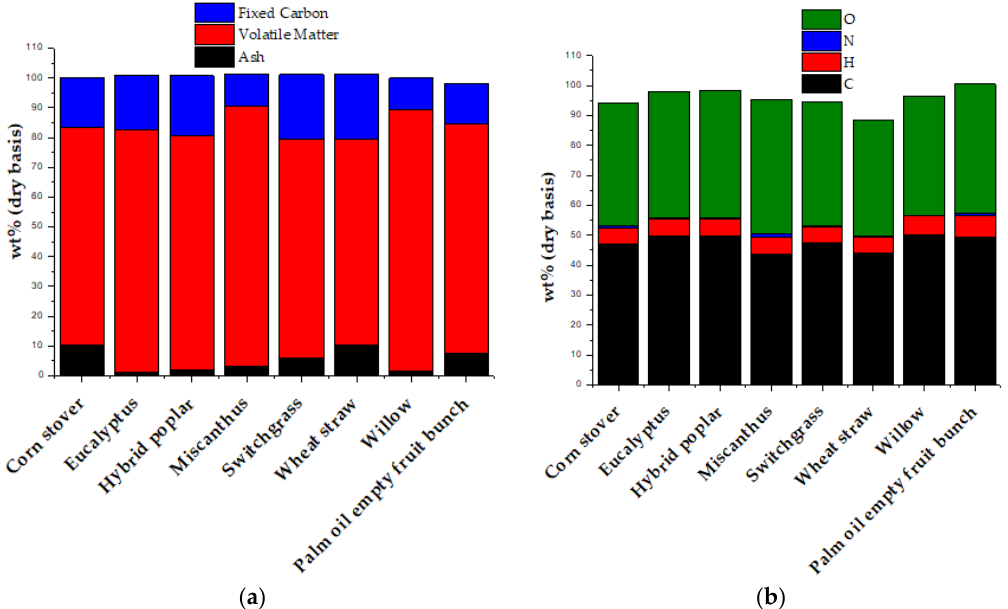
Figure 3. Characterization of Biomass: ( a ) Proximate Analysis and ( b ) Ultimate Analysis, adapted from [32,33].